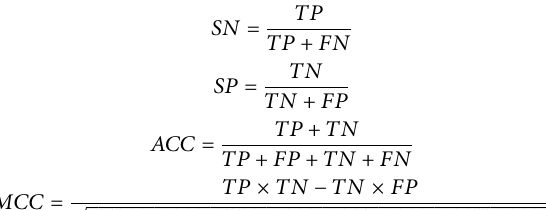
Frontiers in Cell and Developmental